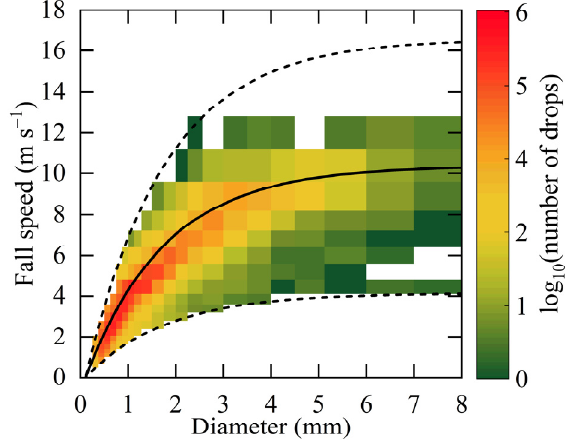
Figure 2. Drop numbers processed for quality control procedure in Zhaosu. The black solid line indicates the empirical drops final speed ‐ diameter relationship from Atlas et al. [56] considering the correction factor of 1.07. The black dashed lines represent the ± 60% range of the empirical relation.